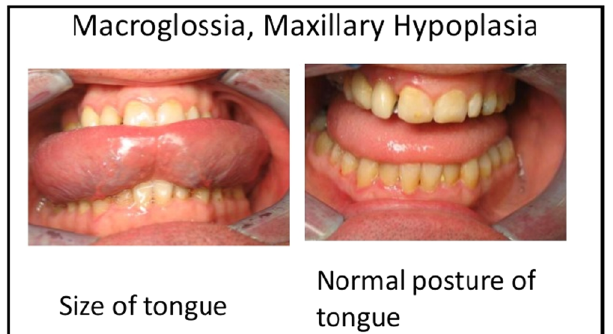
Figure 2: A photographic picture of macroglossia/maxillary hypoplasia from Sara ’ s